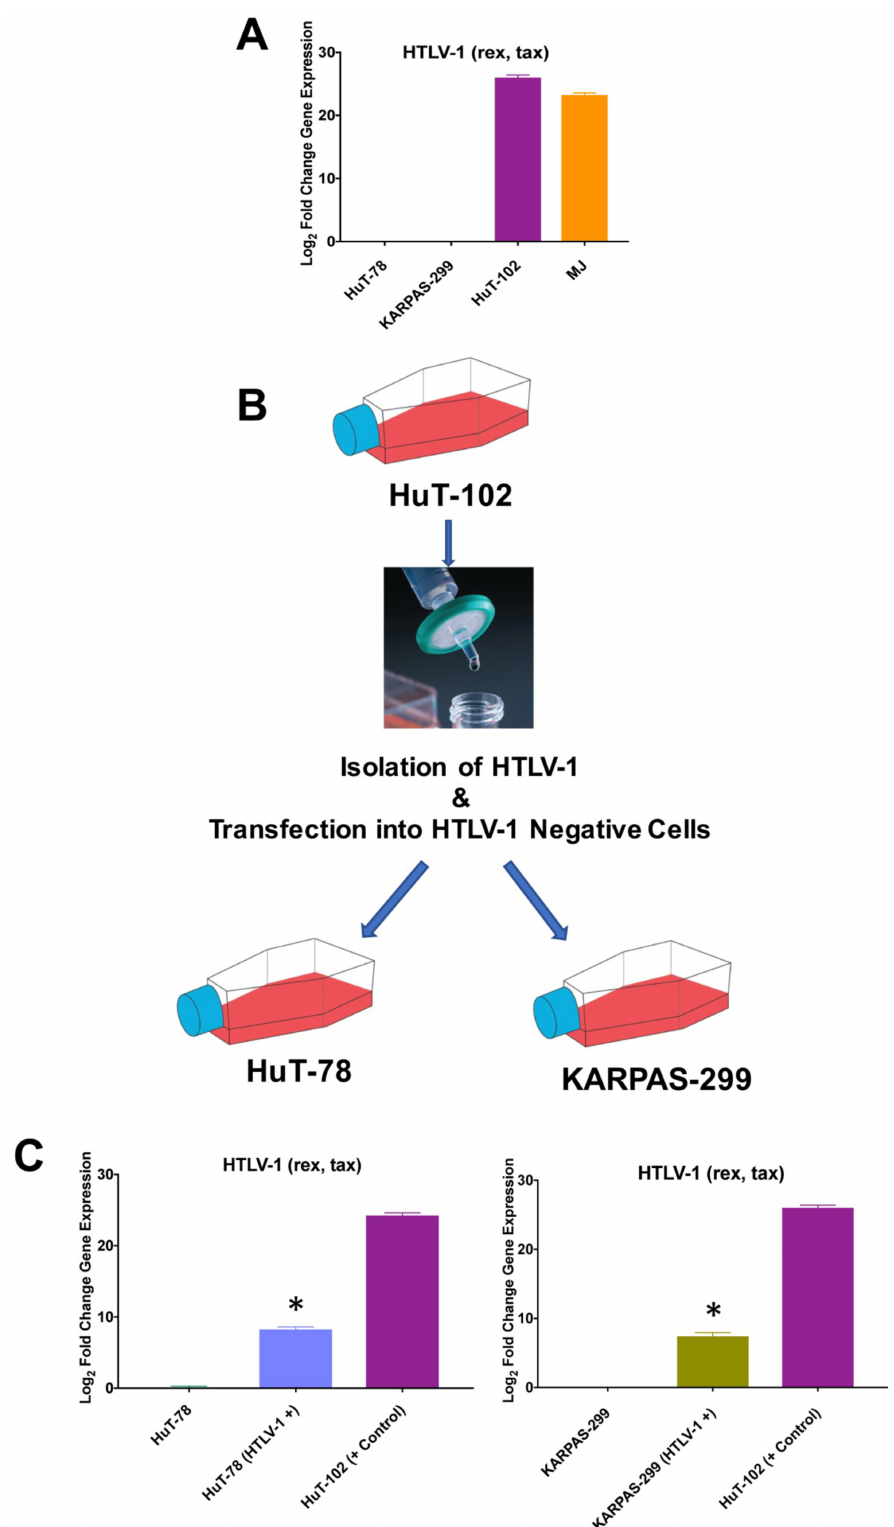
Figure 4. HTLV-1 isolated from HTLV-1-positive HuT-102 cells can infect other TCL cells. ( A ) Quanti- tative detection of HTLV-1 (rex, tax) by qRT-PCR in TCL cells. Mean ± SD, n = 3. ( B ) Transfection of HTLV-1-negative HuT-78 and KARPAS-299 cells by culture filtrate from HuT-102 cells. ( C ) Quantita- tive detection of HTLV-1 (rex, tax) by qRT-PCR in HTLV-1-negative and HTLV-1-infected models. HTLV-1-positive HuT-102 cells served as a positive control. Mean ± SD, n = 3. * Indicates a significant difference compared to non-infected cells, p <